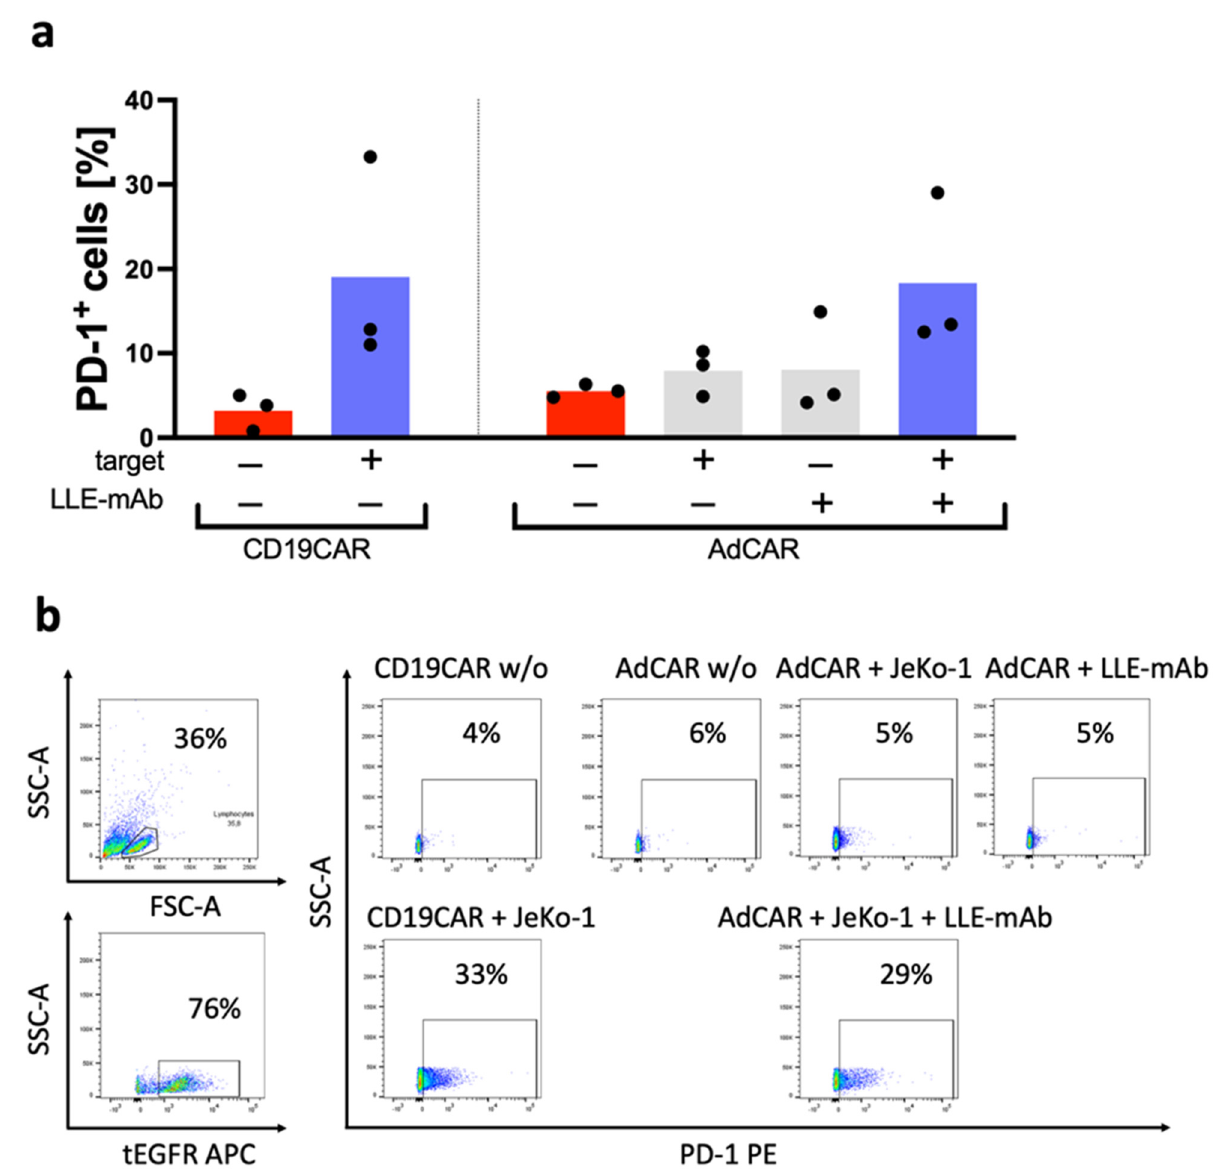
Figure 6. Exhaustion of AdCAR T cells vs. CD19CAR T cells. ( a ) CD19CAR T cells were incubated for 24 h with or without the CD19 + lymphoma cell line JeKo-1. Additionally, AdCAR T cells were incubated for 24 h with or without the CD19 + lymphoma cell line JeKo-1 and with or without 10 ng/mL LLE-CD19 mAb. Exhaustion after incubation was determined by flow cytometry using a PE-labeled PD-1 (CD279) mAb. ( b ) Representative schematic gating strategy of the indicated conditions of CD19CAR and AdCAR expressing cells with and without the target cell line JeKo-1, as well as with or without the LLE-mAb for the AdCAR T cells. PD-1 expression was analyzed and is illustrated for the CAR-positive cells ( left ). Data shown in ( a ) represent the mean ± SEM of (n = 3) independent experiments from three different